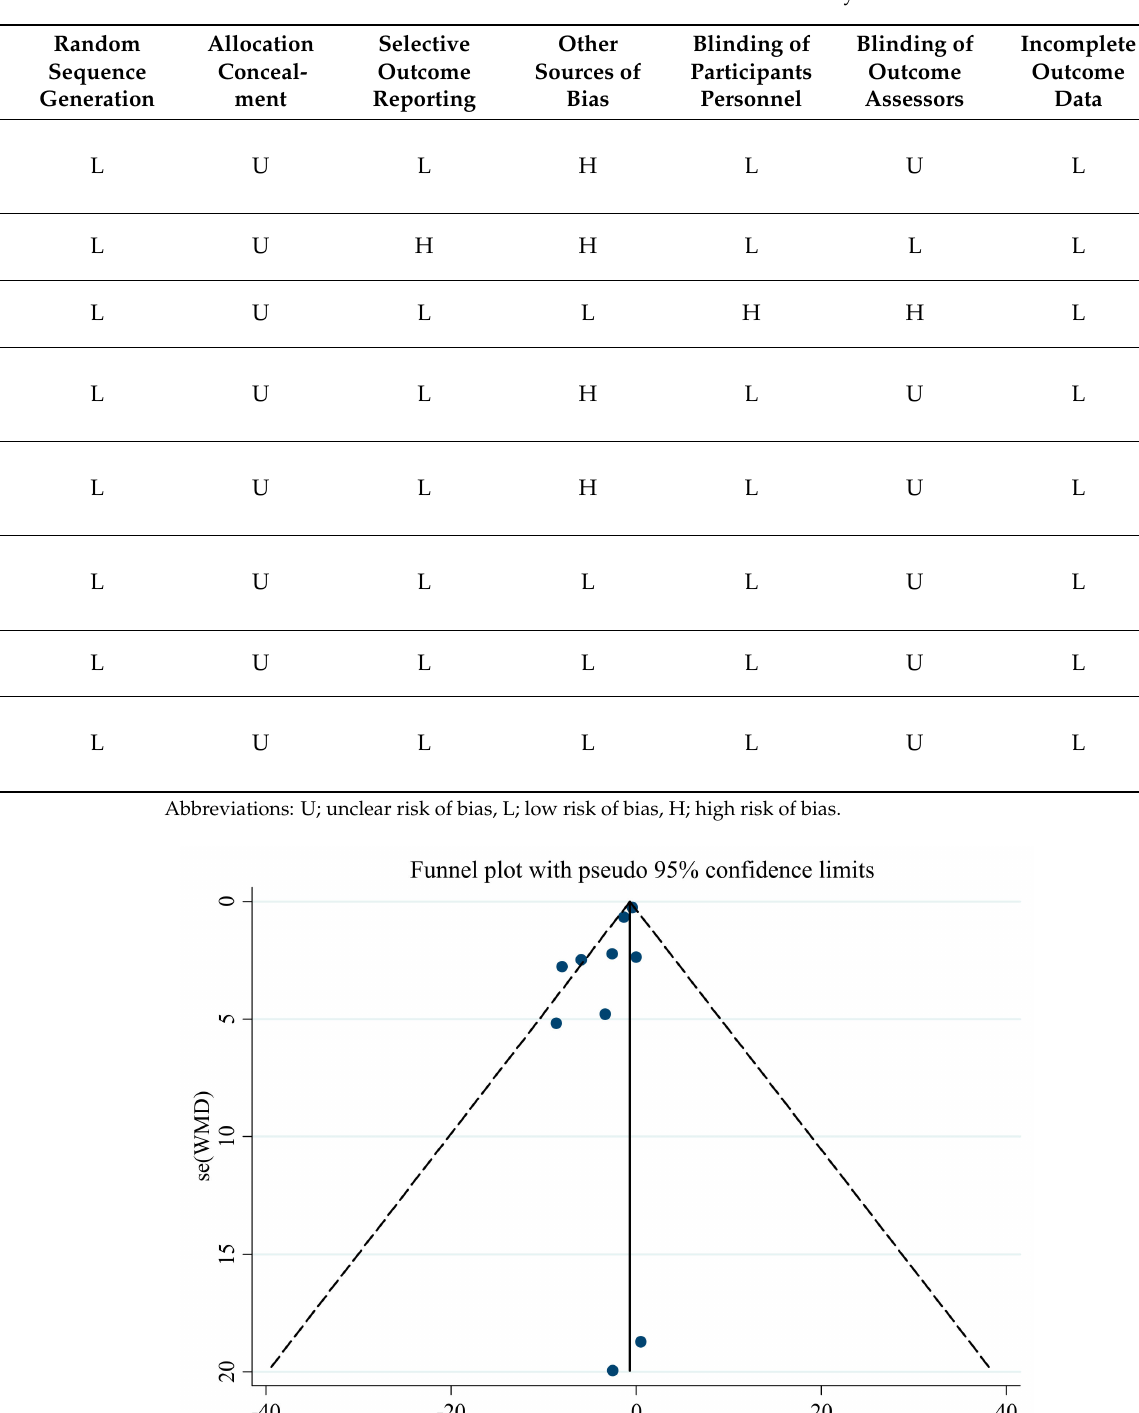
Table 3. Risk of bias assessment of the studies included in this meta-analysis.